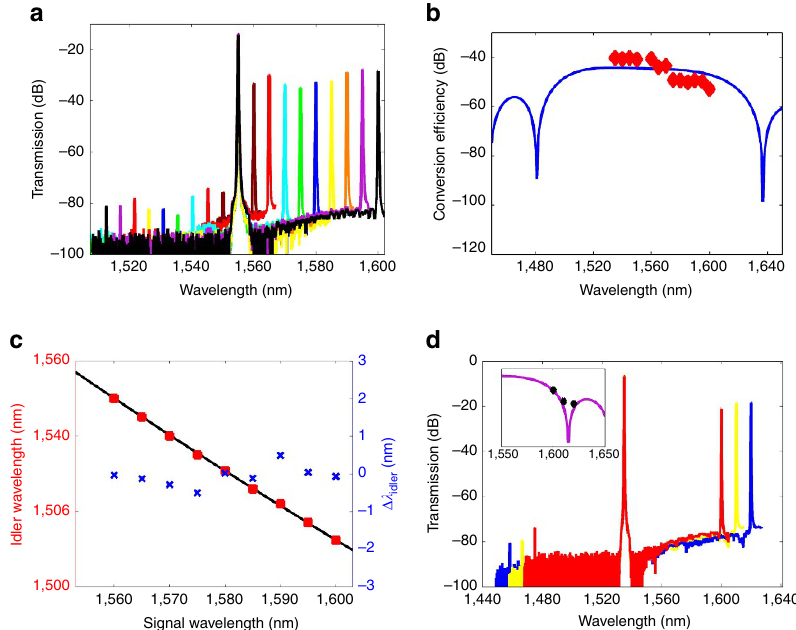
Figure 3 | Broadband low power parametric wavelength conversion in USRN waveguides. ( a ) Generated four-wave-mixing spectra as the signal wavelength is tuned from 1,560 to 1,610nm using a pump located at 1,555nm. Solid lines denote the four-wave-mixing spectra for a signal located at 1,560 (brown), 1,565 (red), 1,570 (cyan), 1,575 (green), 1,580 (blue), 1,585 (yellow), 1,590 (orange), 1,595 (purple) and 1,600nm (black). ( b ) Calculated (blue solid line) and measured (red squares) conversion efficiency as a function of signal wavelength, using a pump located at 1,555nm. ( c ) Measured (red squares) and calculated (black solid line) idler wavelength as a function of the signal wavelength. ( d ) Four-wave mixing using a pump at 1,535nm and signal at 1,620nm representing conversion over 170nm. Solid lines denote the four-wave-mixing spectra for a signal located at 1,600 (red), 1,610 (yellow) and 1,620nm (blue). Inset shows the calculated (purple line) and measured (black diamonds) conversion efficiency as a function of wavelength.